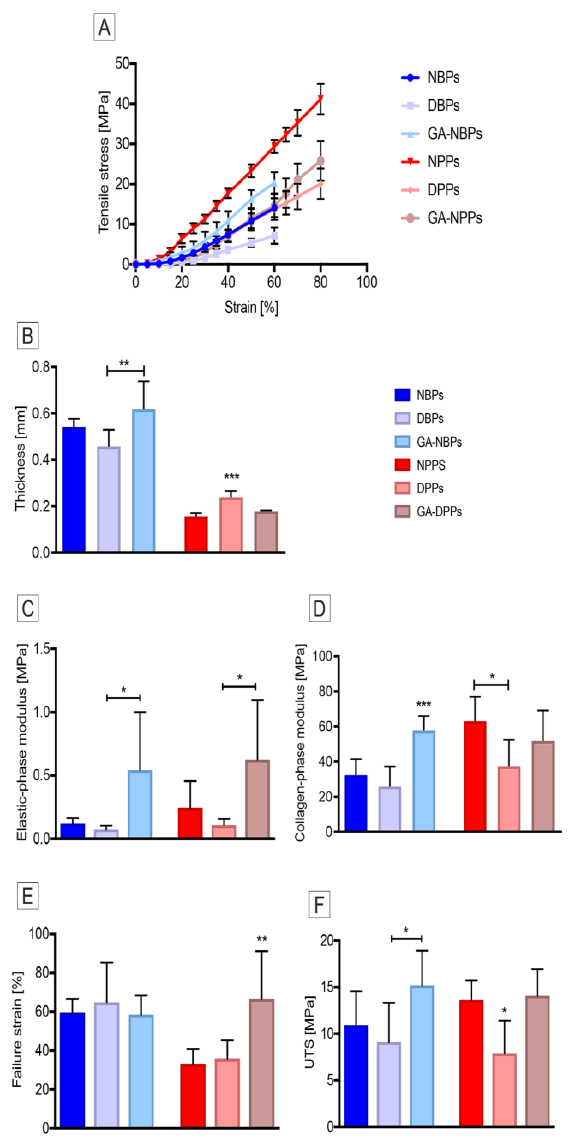
Figure 7. Biomechanical properties of bovine and porcine pericardia before and after TRICOL decellularization. ( A ) Stress-strain curves. Typical J-shaped curves of soft tissues were appreciated for all tested pericardial samples. ( B ) Thickness. As compared to native tissues, TRICOL decellularization induced no significant changes in bovine pericardium thickness, while varied porcine one. Glutaraldehyde (GA) increased significantly the thickness of bovine pericardium, but decreased that of porcine sca ff old. ( C ) Elastic-phase modulus. TRICOL decellularization had no e ff ects on elastic-phase modulus. ( D ) Collagen phase modulus. After TRICOL decellularization, both bovine and porcine pericardial sca ff olds showed a decrease in collagen phase modulus, although significant only for the second species. GA significantly increased collagen phase modulus of bovine pericardium. ( E ) Failure strain. No significant failure strain modifications were reported after TRICOL decellularization, while a significant rise was observed after GA treatment in porcine tissues. ( F ) Ultimate tensile strength (UTS). TRICOL decellularization tended to reduce ultimate tensile strength of both species’ tissues, without any statistical significance. The data are presented as mean ± standard deviation (SD). * p < 0.005, ** p < 0.01, *** p < 0.001. NBP= Native Bovine Pericardium, DBP= Decellularized Bovine Pericardium, NPP= Native Porcine Pericardium, DPP= Decellularized Porcine Pericardium, and GA= Glutaraldehyde.